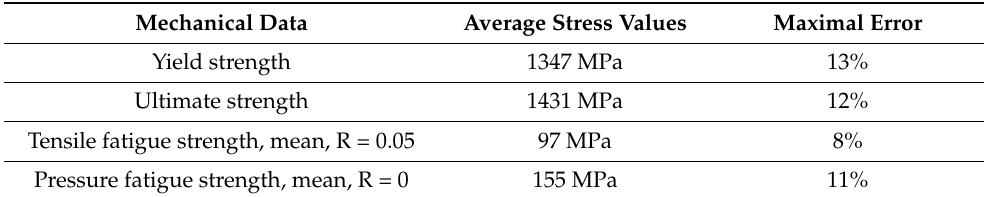
Table 5. Calculated material data.